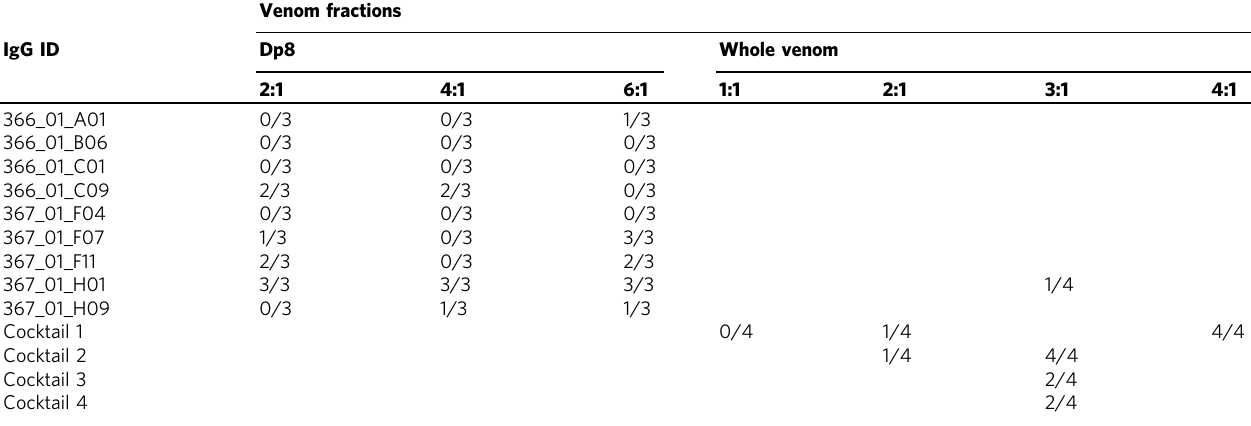
Table 3 In vivo neutralization results for monoclonal IgG antibodies raised against Dp8 and oligoclonal IgG cocktails Venom